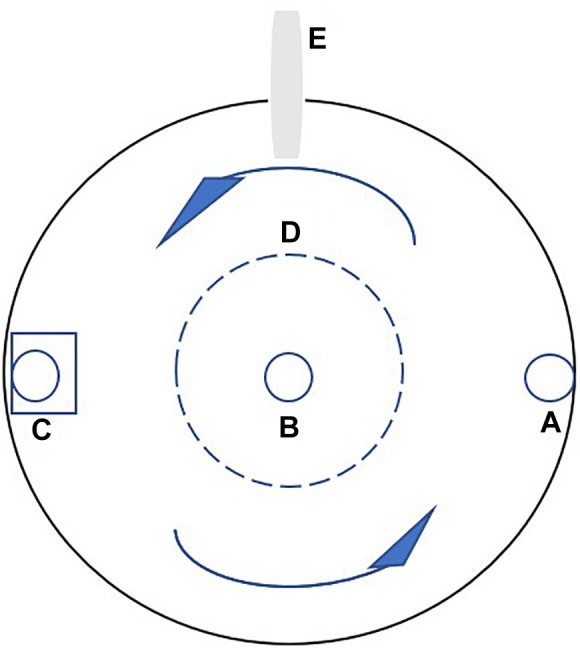
The platform of the experimental tank. (A) The water inlet, (B) the water outlet, (C) the pump with a vertical perforated pipe, (D) plastic hoarding, and (E) the feeding tube of the self-feeder. The arrows indicate the current direction.